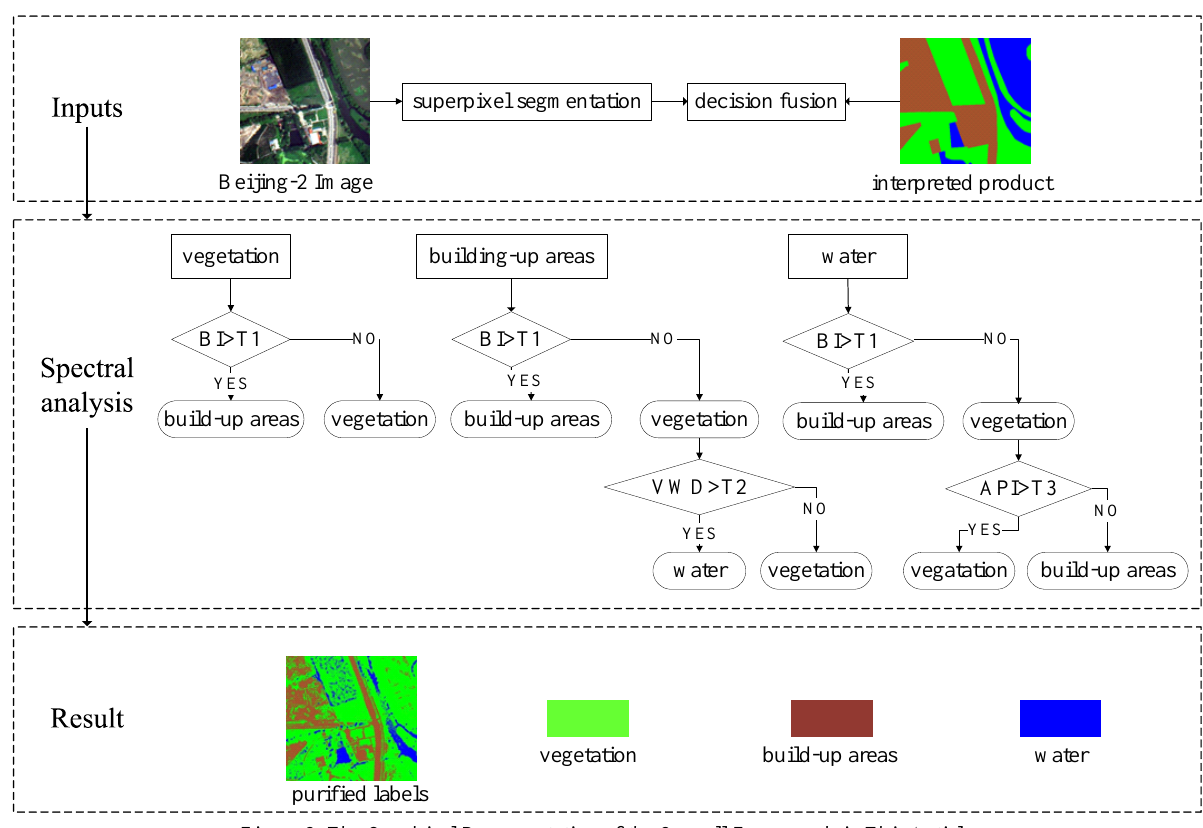
Figure 3. The Graphical Representation of the Overall Framework in This